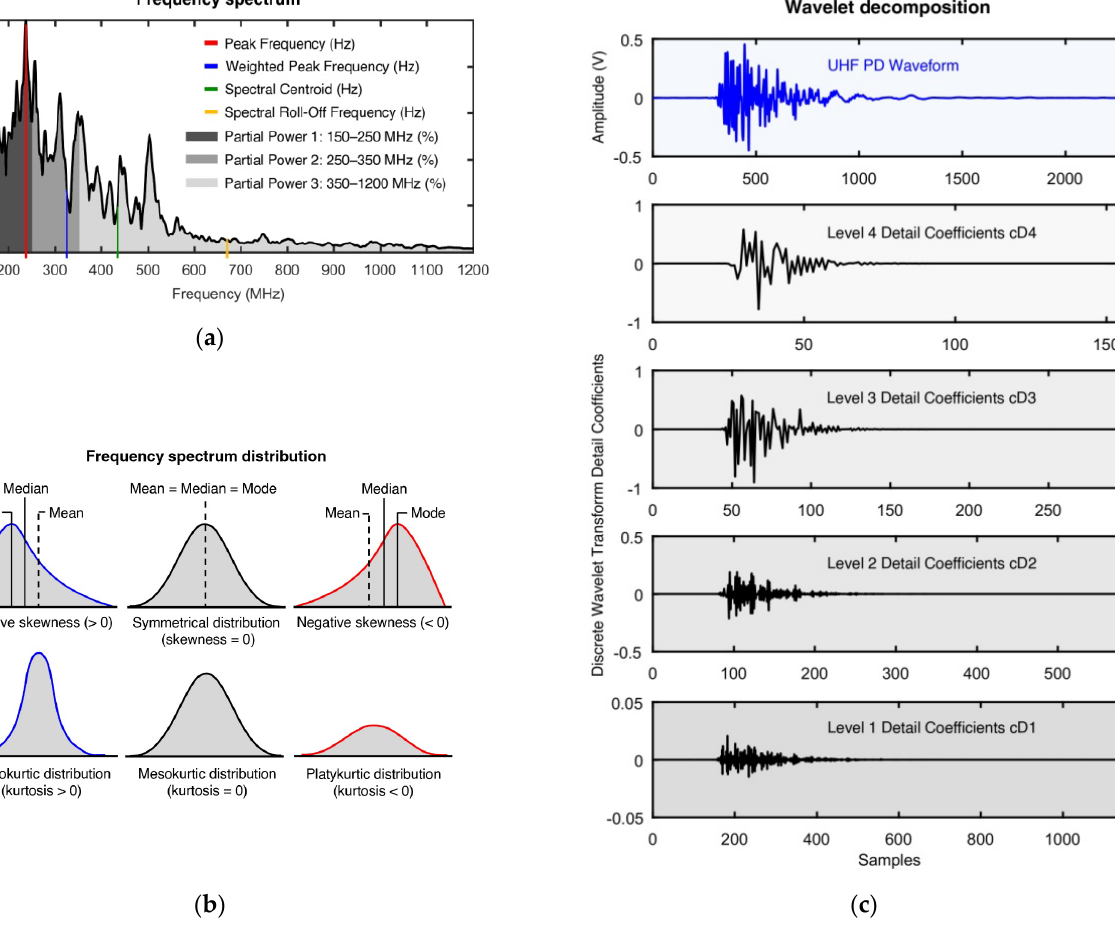
Figure 4. Graphical representation of the selected features used in the machine learning process: ( a ) Frequency-domain features (peak frequency, weighted peak frequency, spectral centroid, spectral roll-off frequency, partial powers); ( b ) Higher-order statistical features in the frequency domain (skewness and kurtosis of the frequency spectrum); ( c ) Wavelet-domain features (energy of details coefficients of a discrete wavelet transform calculated at four decomposition levels).